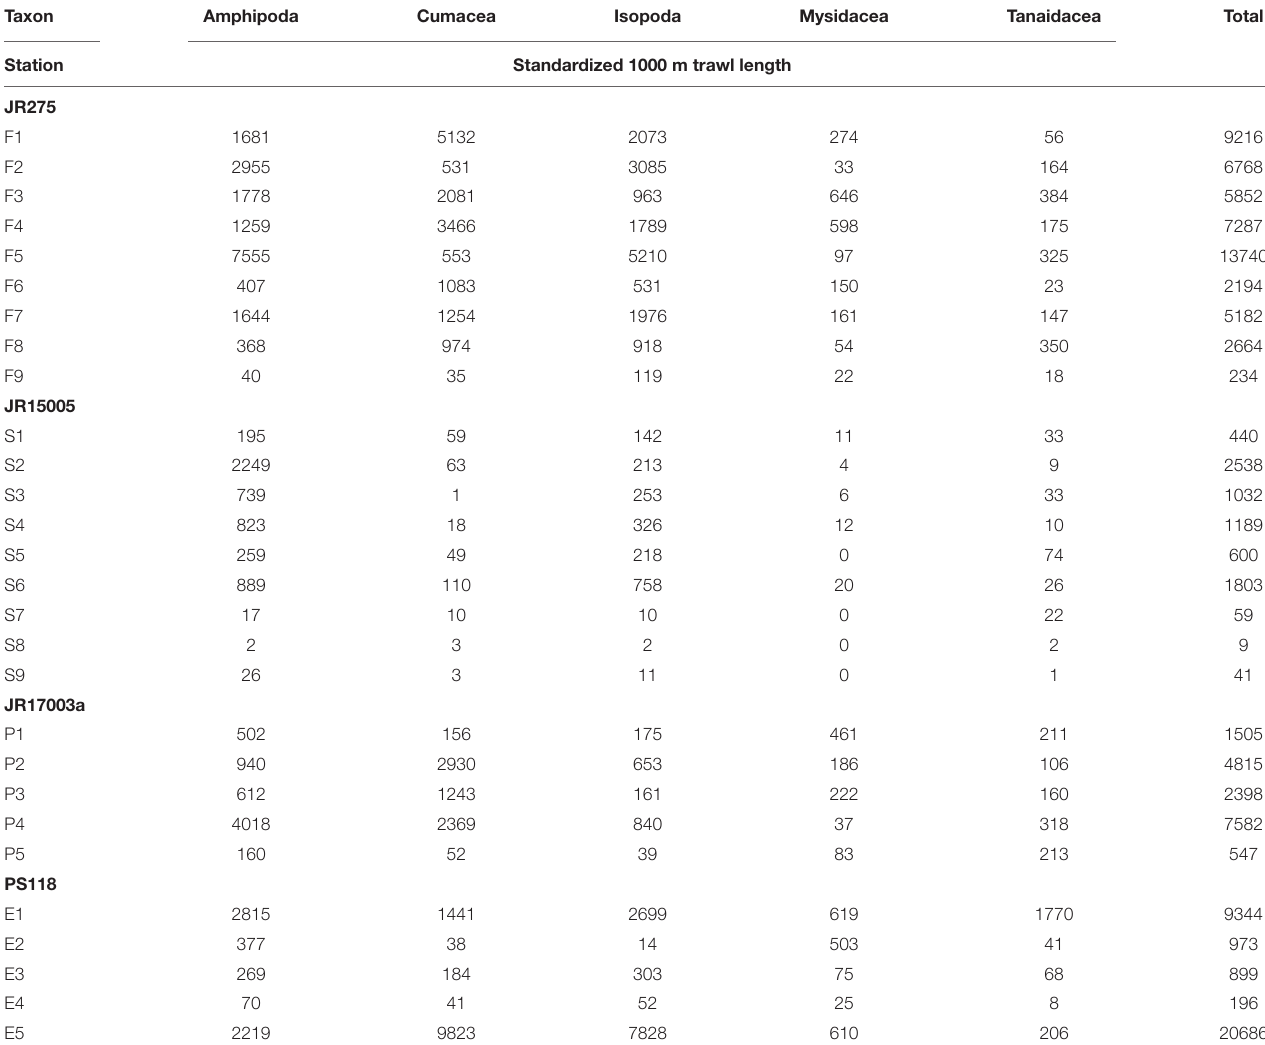
TABLE 2 | Standardized abundance of peracarid orders from all